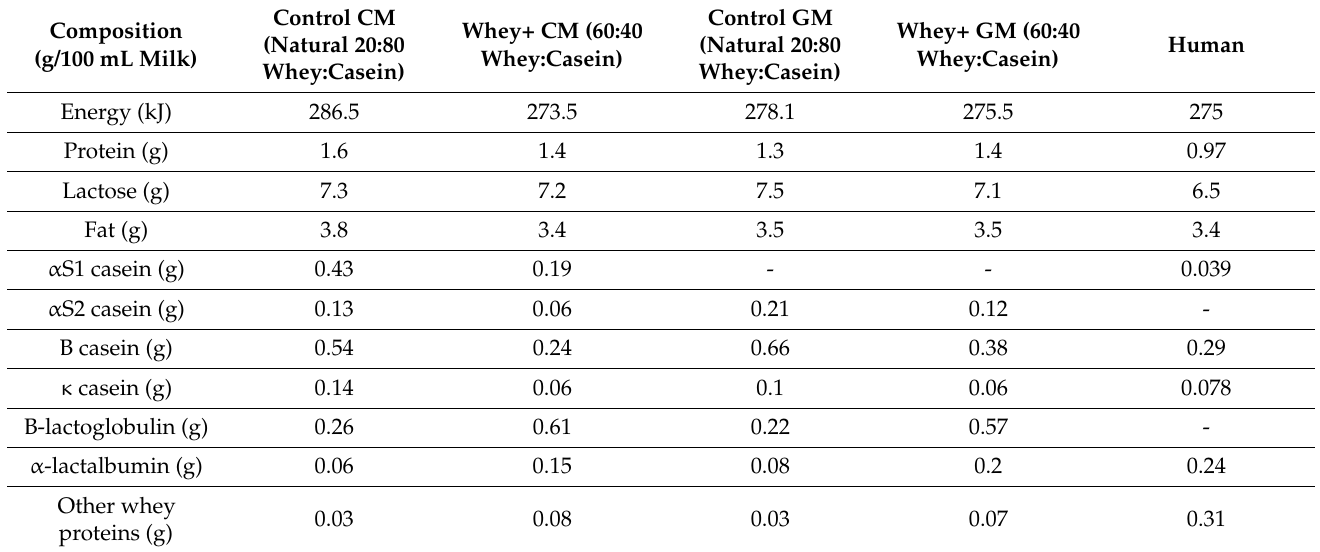
Table 1. Nutritional composition of CM and GM formulations per 100 mL of prepared solutions. For reference, the last column shows composition of human